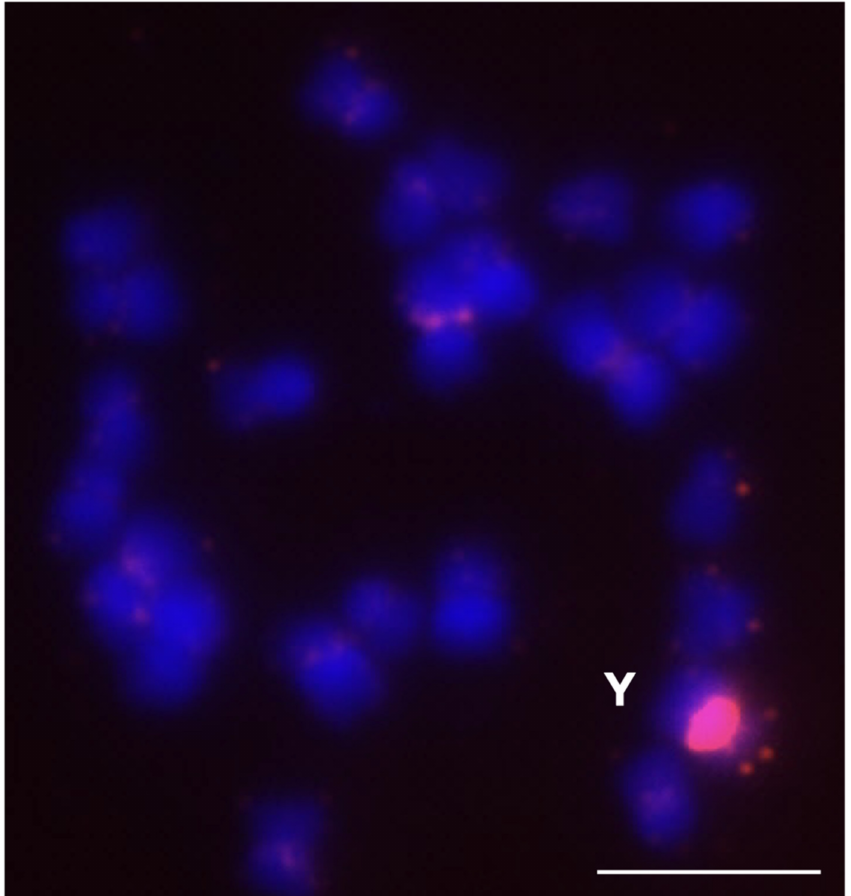
Figure 9. Localization of the HRTR12 tandem repeat on the metaphase chromosomes of Hippophae rhamnoides using fluorescence in situ hybridization. Red signal indicates the chromosomal localization of the HRTR12 tandem repeat. The letter “Y” corresponds to Y chromosome. The bar indicates 5 µ